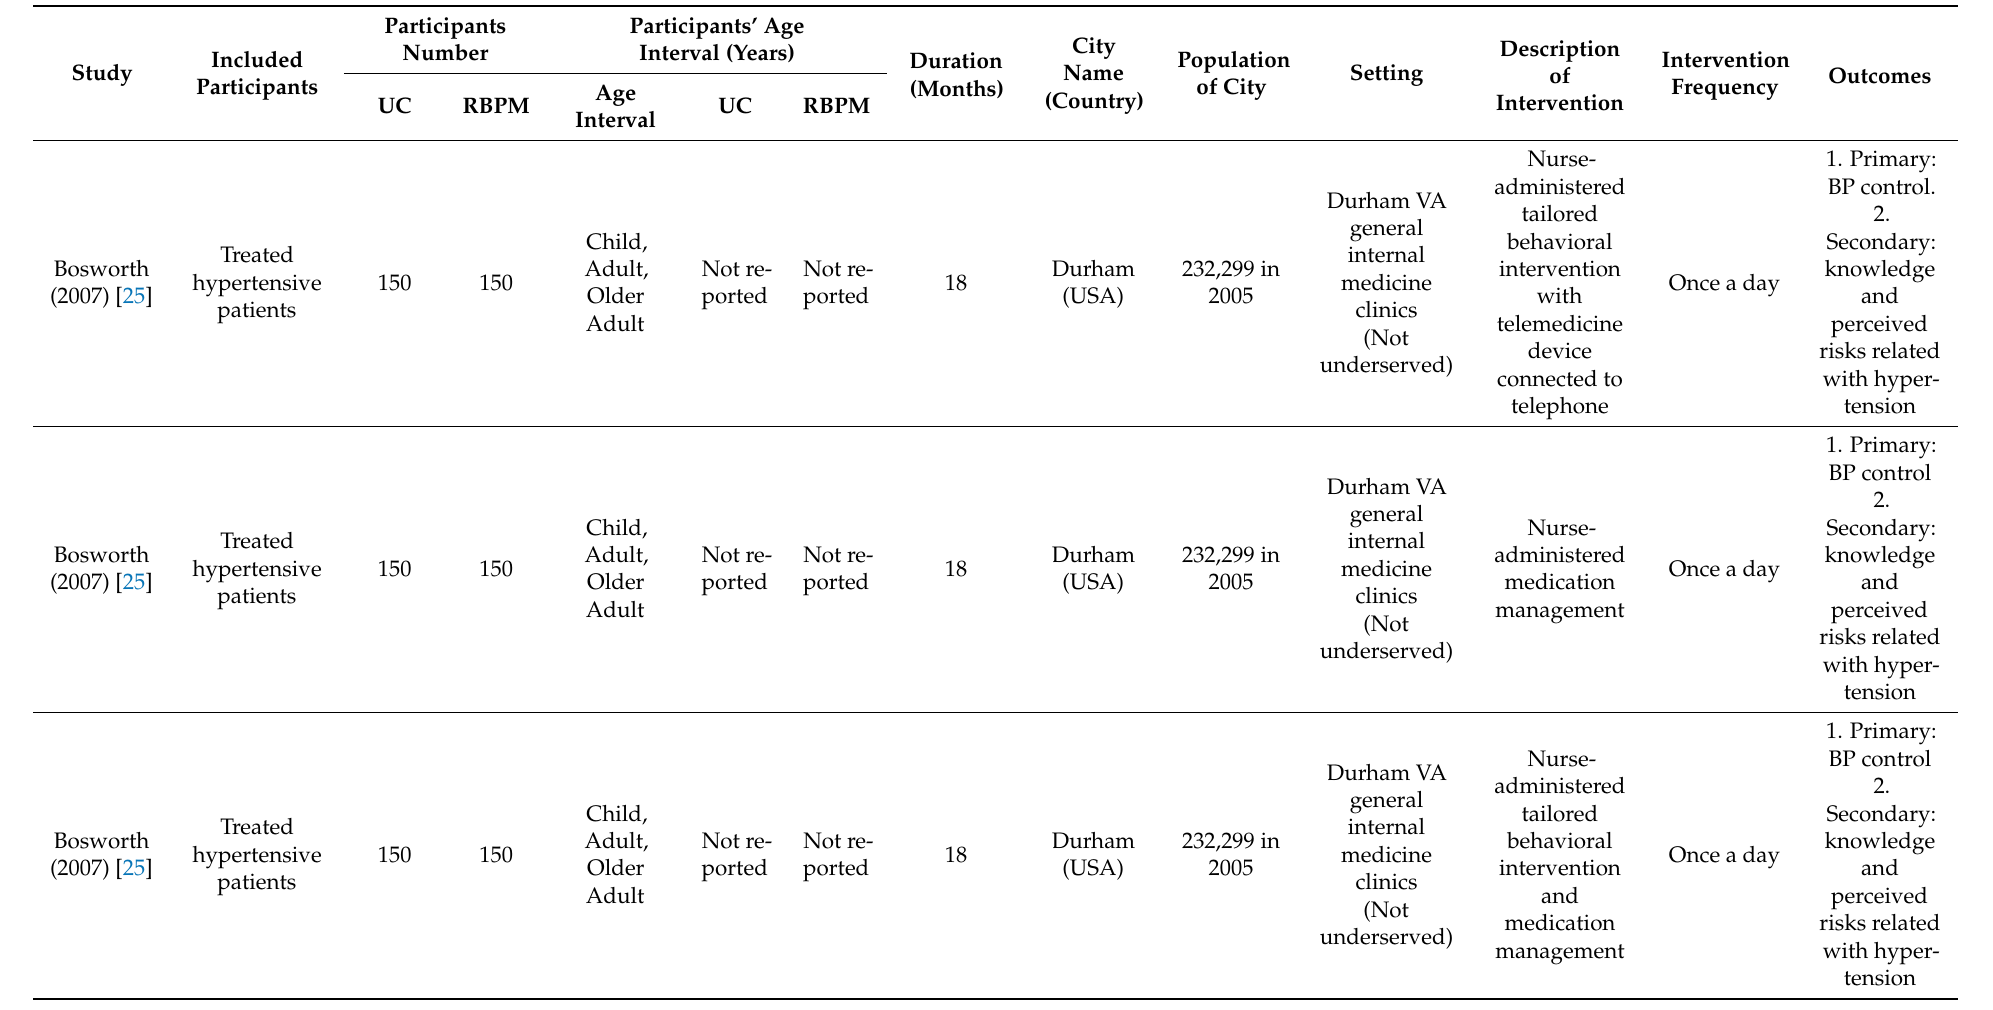
Table 1. Characteristics of individual primary